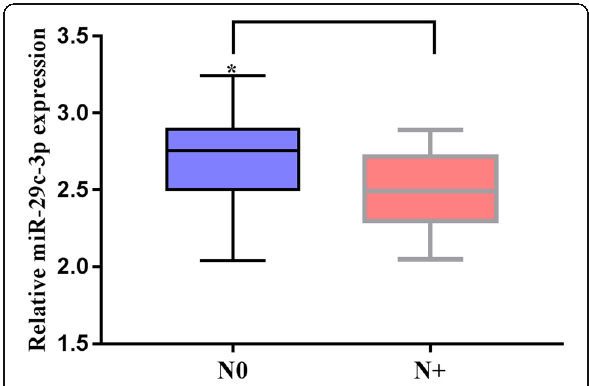
Fig. 2 Relationship between miR-29c-3p and lymph node metastasis. * P <